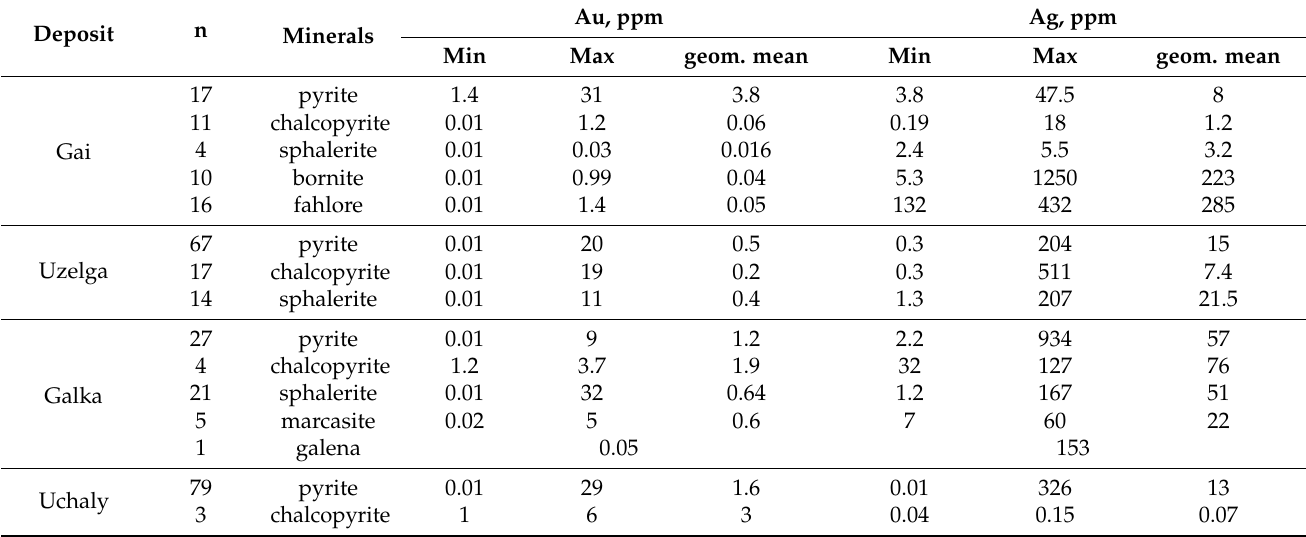
Table 20. Summary data on contents of Au and Ag in ore minerals of VMS deposits according to LA-ICP-MS analysis. Deposit